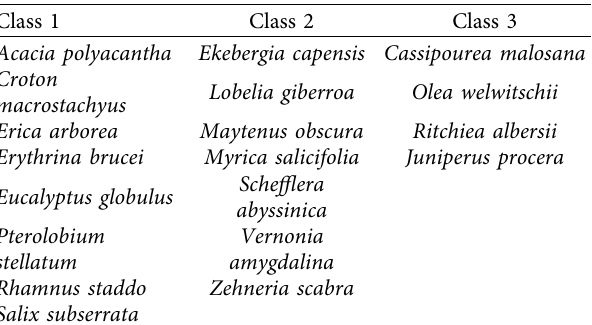
Figure 11: Four regeneration patterns of selected species in Jib Godo Natural Forest. Key: seedling (SE), sapling (SA), and mature (MA) distributions. (a) Inverted J shape, (b) I shape, (c) J shape, and (d) U shape. Table 9: Classifcation of woody species in the diferent conser- vation priority